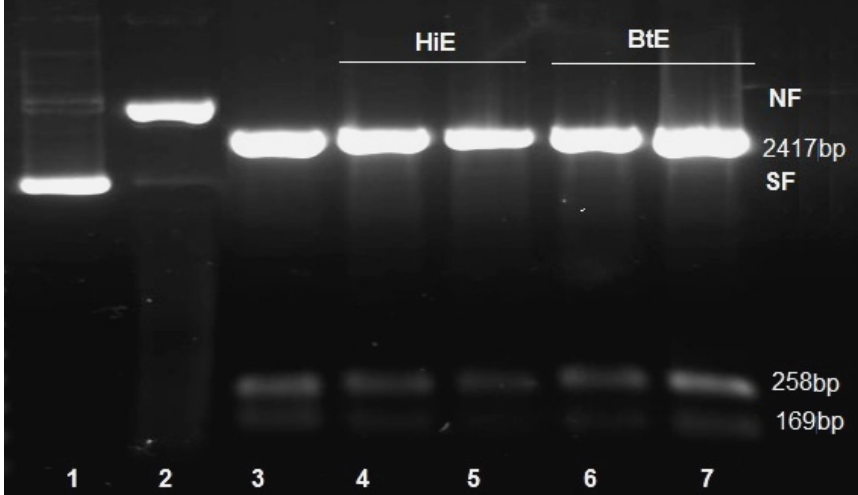
Figure 3. Inhibition of restriction enzymes ( Eco RI, Bam HI and Pvu II) activities by B. triquetrum and H. incrassata extract. (1) Negative control; (2) Positive control; (3) DNA digested with restriction enzymes; (4,6) extract-DNA incubation previous to enzyme addition; (5,7) extract-enzyme incubation previously to DNA